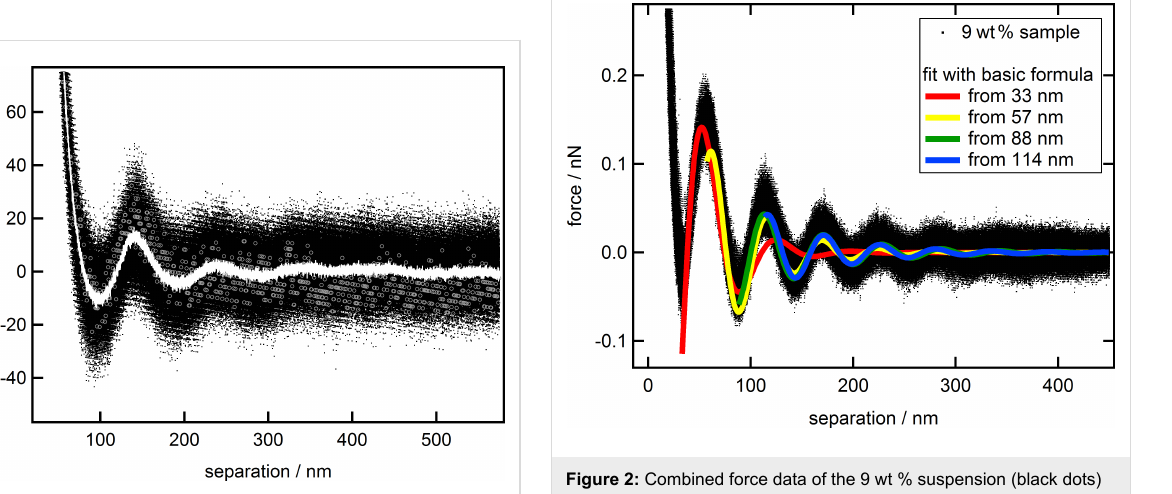
The impact of this method is shown by comparing the signifi- cance of a single force curve with the combined master curve. The single force curve (open grey circles) only shows one